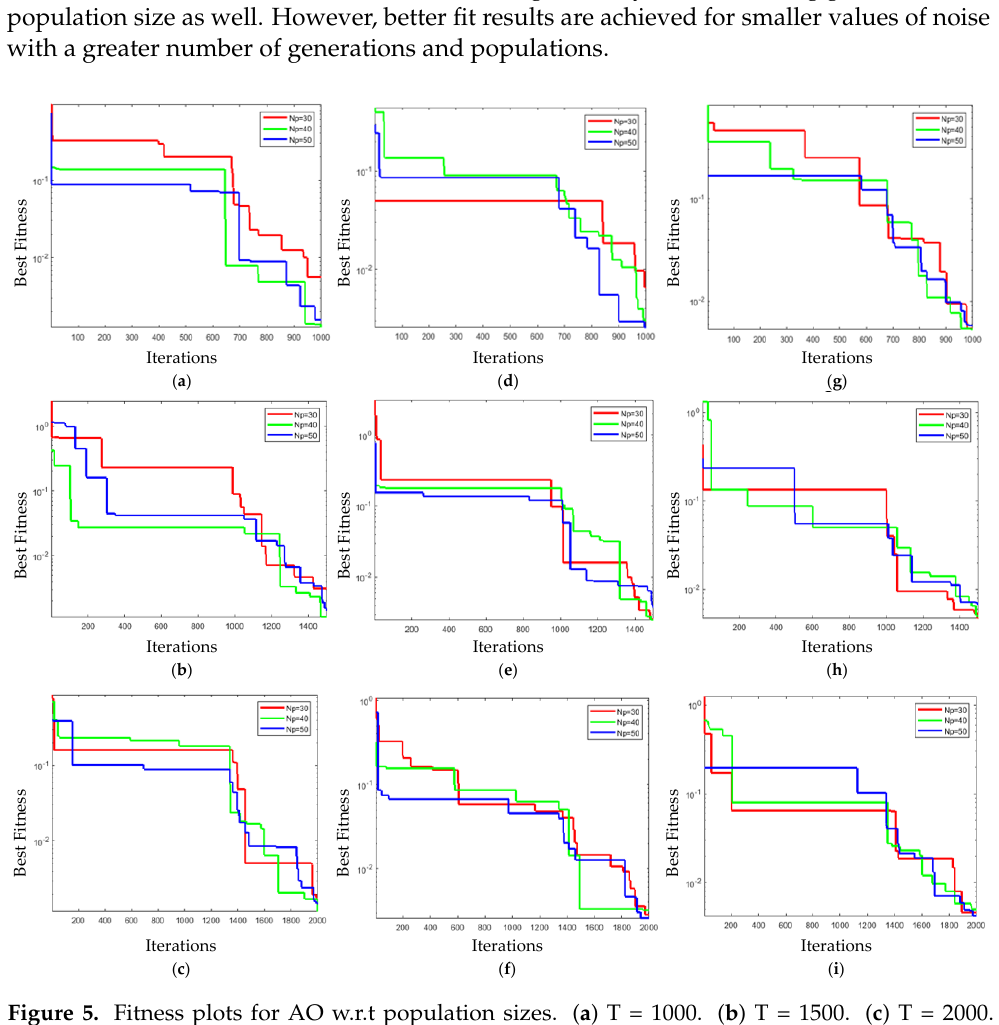
Figure 5. Fitness plots for AO w.r.t population sizes. ( a ) T = 1000. ( b ) T = 1500. ( c ) T = 2000. ( d ) T = 1000. ( e ) T = 1500. ( f ) T = 2000. ( g ) T = 1000. ( h ) T = 1500. ( i ) T = 2000. To confirm the natural behaviour of the AO strategy for different noise values, the performance of the AO method is also verified by fixing the population size (30, 40, or 50) and changing the generation size (1000, 1500, or 2000) for three values of noise variance (0.04, 0.06, and 0.08), and the fitness-based learning curves are presented in Figure 6. Fig- ure 6a–c represent the AO fit with population = 30, and the fitness plots for population = 40 are given in Figure 6d–e. Figure 6g–i denotes the fitness plots for population = 50. It is realized from the fitness curves given in Figure 6a–i that for a fixed population and gen- eration size, the AO fit for low levels of noise, i.e., 0.04 and 0.06, is quite lower than the fit for high noise, i.e., 0.08. Nevertheless, AO accomplishes the minimum fit for the smallest noise level, i.e., 0.04, for fixed population size. Therefore, it is confirmed from the curves in Figure 6 that the performance of AO degrades noticeably for higher noise values. B e s t F i t n e ss